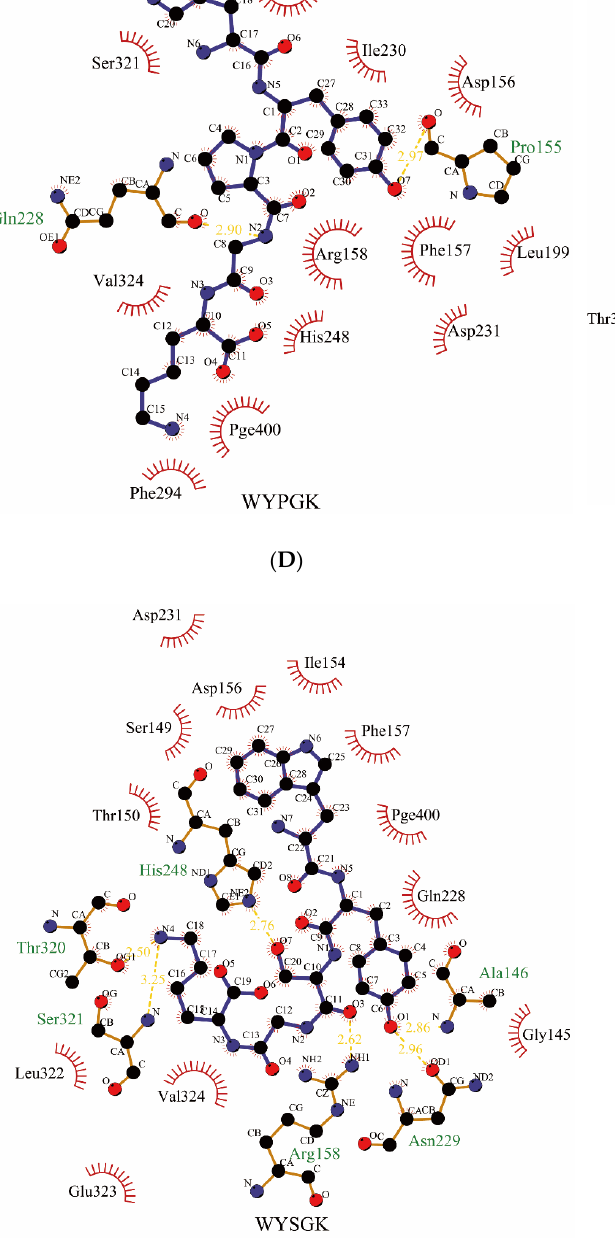
Figure 1. The molecular docking mode of ( A ) WYPGK, ( B ) WYFGK and ( C ) WYSGK with SIRT3. The yellow dashed lines stand for hydrogen bonds. The interaction between peptides and the residues of the binding sites in SIRT3 are shown using a 2 D diagram by LigPlus software. ( D ) WYPGK, ( E ) WYFGK and ( F ) WYSGK.